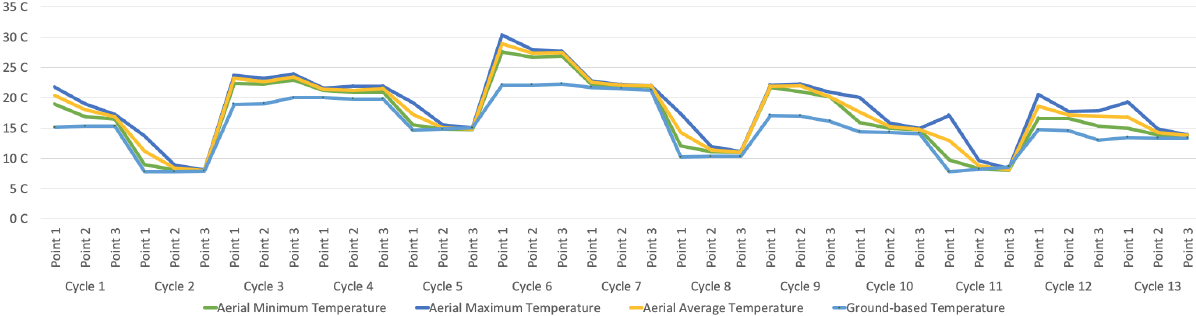
Figure 5. Aerial minimum, average, and maximum temperature compared with ground-based